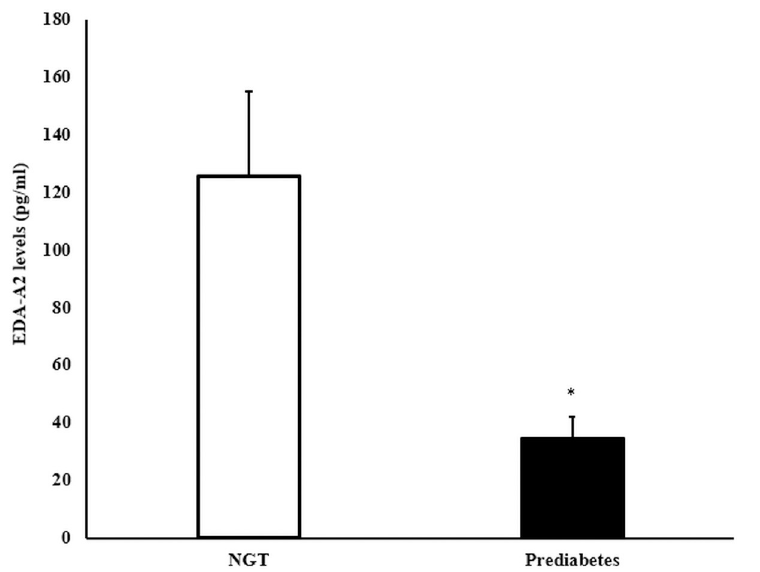
Fig 4. EDA-A2 levels (pg/ml) by prediabetes status. Values are mean ± SEM. � p <